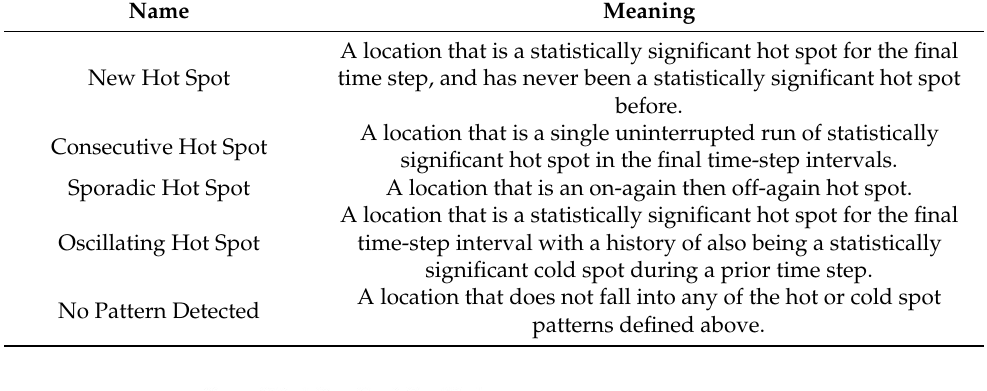
Table 3. Definitions of different hot spots [56].